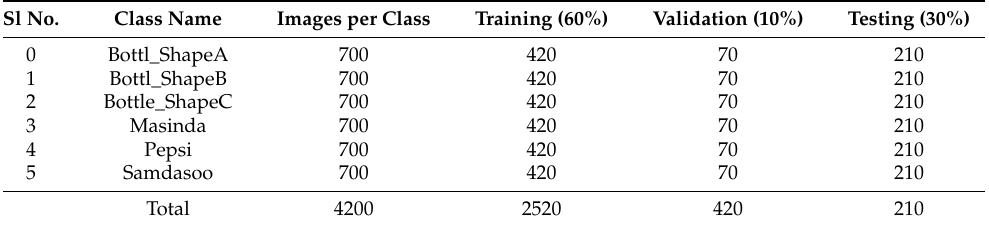
Table 2. Details of the dataset after data augmentation using both augmentation techniques. Sl No.